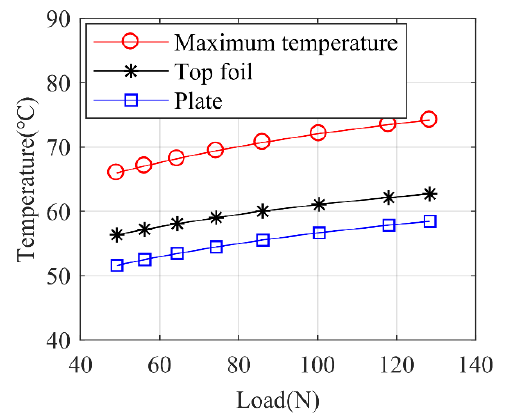
Figure 12. Relationship between bearing temperature and